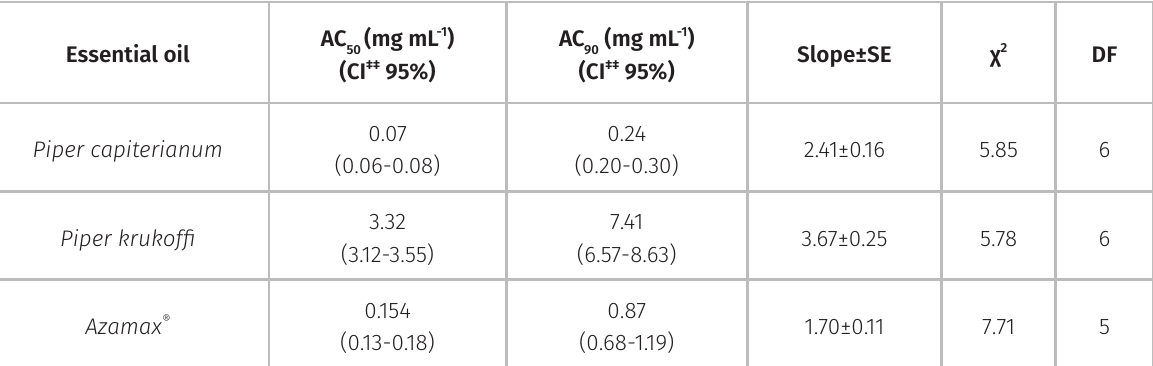
Table III. Antifeedant activity of the Piper essential oil against Plutella xylostella .